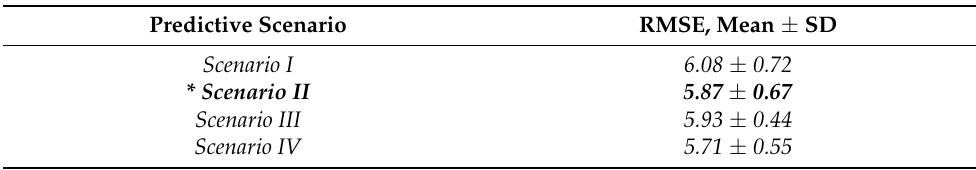
Table 4. External validation of the best prediction model (LightGBM) obtained from MIMIC-III to obtain the MV duration prediction in the eICU